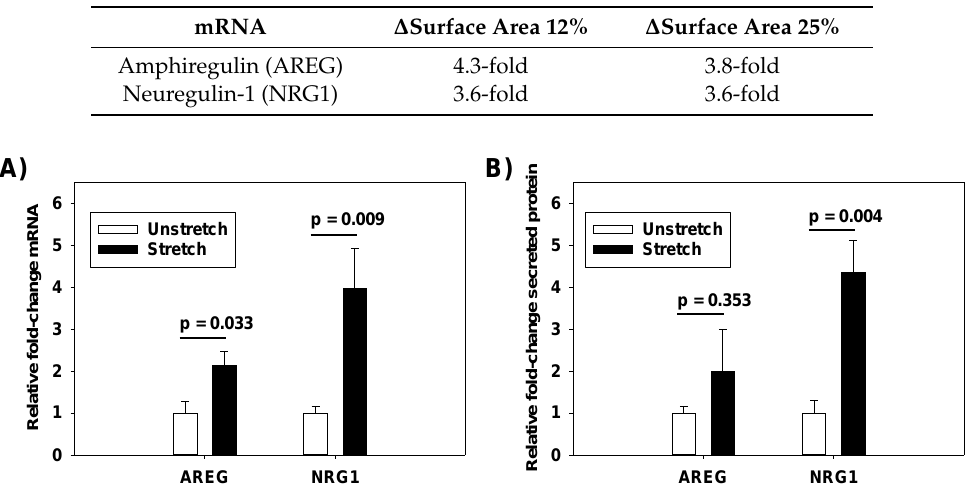
Figure 1. Increases in ( A ) mRNA and ( B ) secreted protein with cyclic stretch (ΔSA 37%, 0.25 Hz, 1 h) as measured by RT-PCR or Western blot analysis. Values are normalized to unstretched cells. n = 5; p values represent the result of unpaired t -tests.